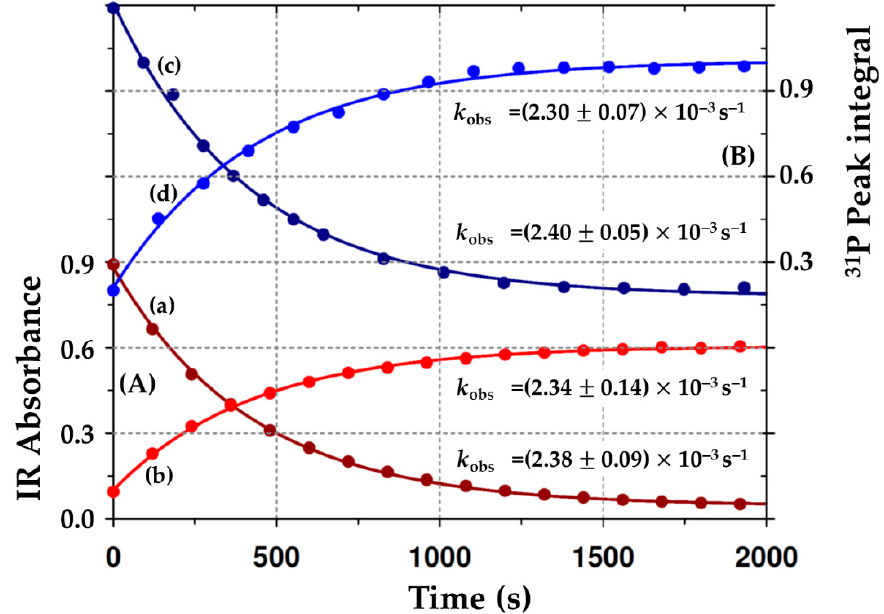
Figure 6. First-order fits to Equation (1) (Section 4.2) of the kinetic process at 25 ◦ C in dichloromethane defined by the disappearance of the [Rh(Indoli)(CO)(PPh 3 )] ( A2 ) species, and the concurrent formation of the Rh(III)-alkyl species ( A3 ). (A) In Red: IR Absorbance changes vs. time from Figure 2: (a) Disappearance of Rh(I); (b) formation of Rh(III)-acyl; ([ A2 ] = 0.01 M; [MeI] = 1.0 M). (B) In blue: 31 P{ 1 H} peak integral changes vs. time from Figure 3: (c) Disappearance of Rh(I); (d) formation of Rh(III)-acyl; ([ A2 ] = 0.02 M; [MeI] = 1.0 M). The data points represent the observed IR absorbance values/ 31 P NMR peak integrals, while the lines give the least-squares data fits to yield the pseudo first-order rate constants.